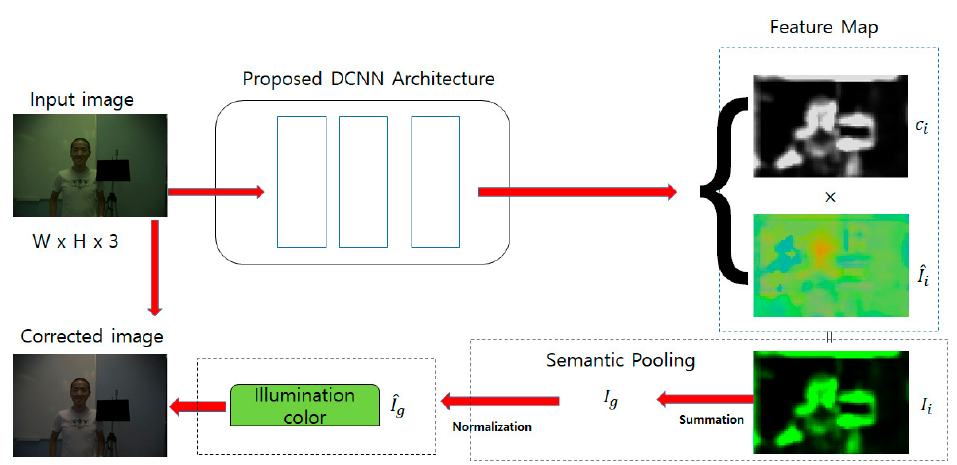
Figure 1. Block diagram of the proposed method.